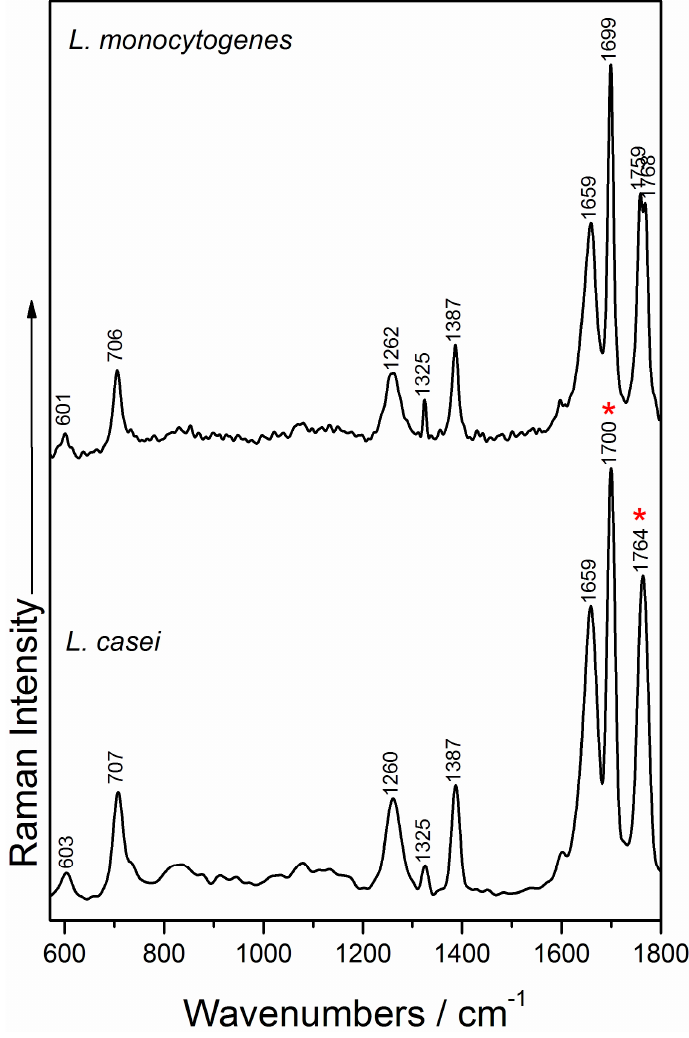
Figure 4. Raman spectra of L. casei (bottom) and L. monocytogenes (top).The “*” symbol indicates the Raman bands contributing to the principal component analysis (PCA) discrimination.